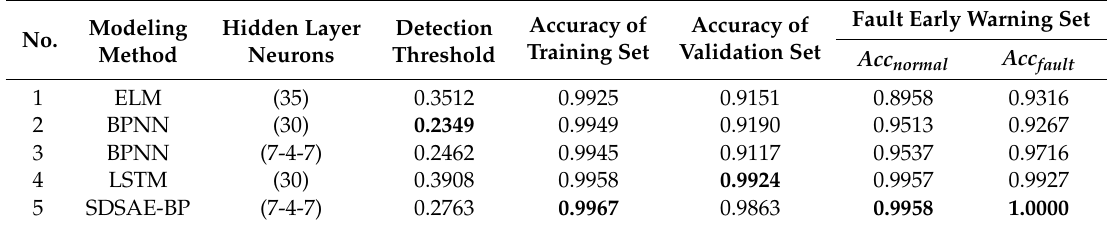
Table 4. Performance comparison of di ff erent modeling